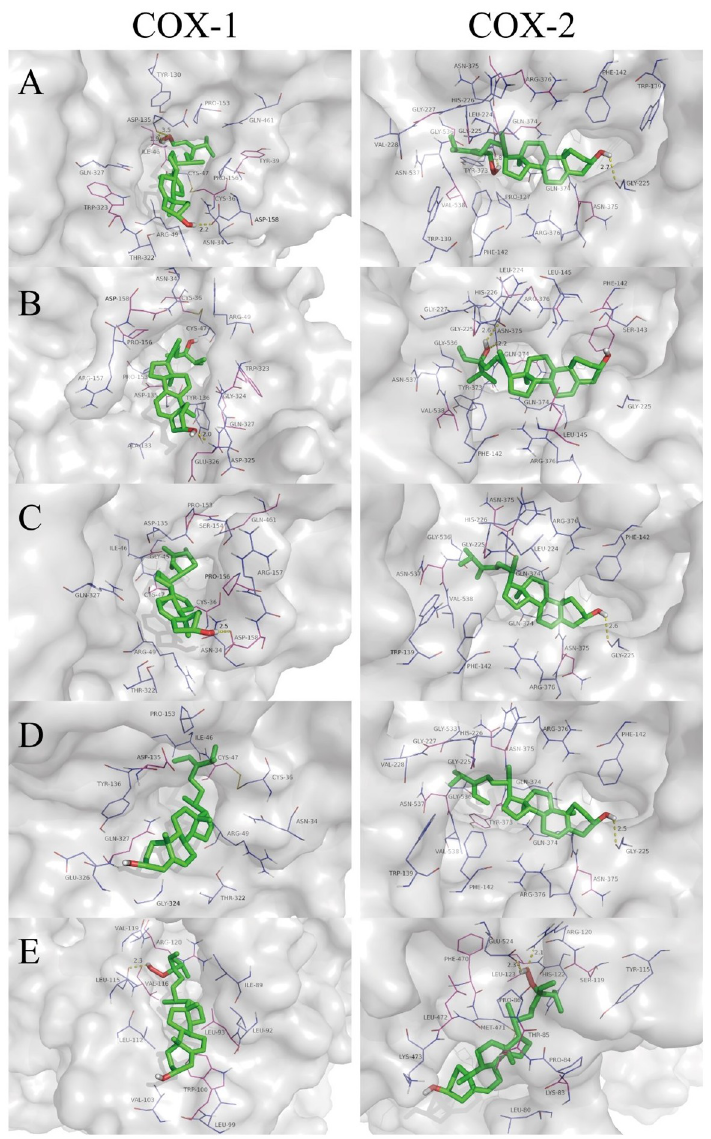
Fig 6. 3-D docked poses of COX-1 and -2 with five sterols (compounds 1–5). The first column represents COX-1 and the second column represents COX-2. The rows present: A) compound 1, B) compound 2, C) compound 3, D) compound 4, E) compound